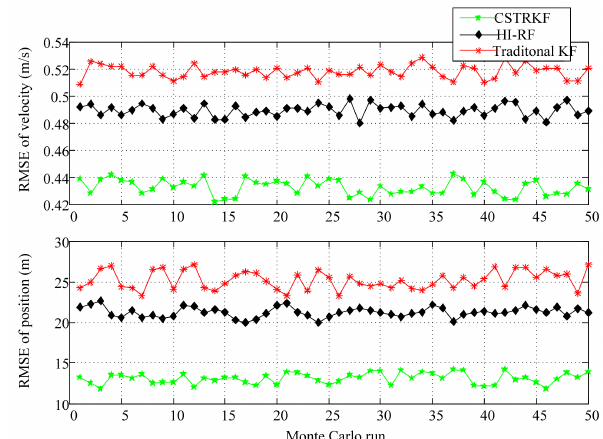
Figure 6. Root-mean-square errors (RMSEs) of velocity and position in the INS / SRS / CNS integrated system with di ff erent filters at the times when measurements have outliers.